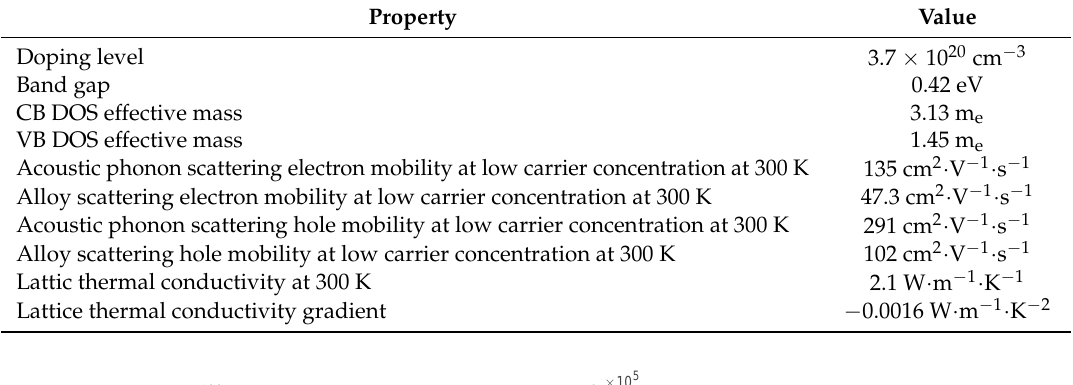
Table 2. Properties used to match modelled n-type silicide material to experimental data. Property